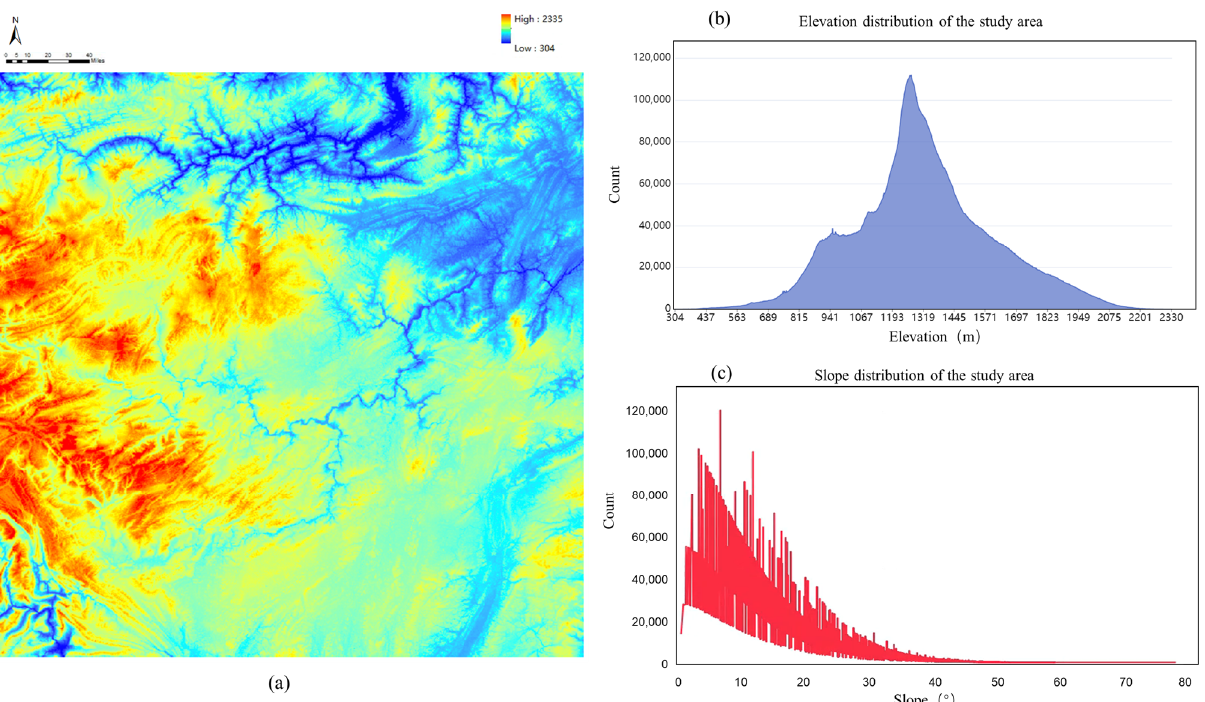
Figure 6. Study area and its elevation and slope parameters: ( a ) is the DEM of the study area, ( b ) is the elevation distribution of the study area, and ( c ) is the slope distribution of the study area.